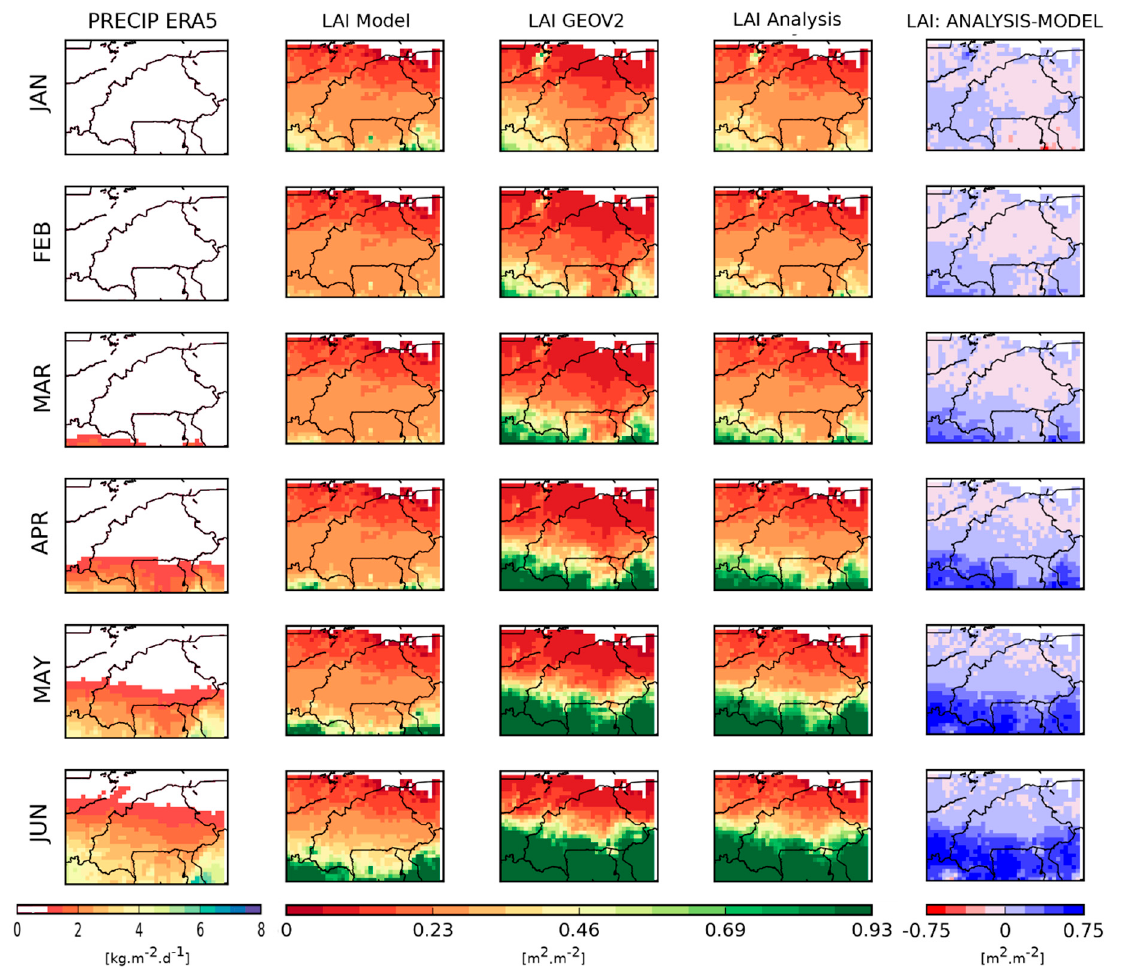
Figure 7. Seasonal average (from January to June) maps of precipitation [kg · m − 2 · d − 1 ] and LAI [m 2 · m − 2 ] over January 2001 to June 2018. From left to right: precipitation, LAI model, LAI analysis, LAI analysis-model difference. The latter column shows the impact of assimilating LAI and SWI on the simulated LAI. LDAS-ERA5 configuration is used.